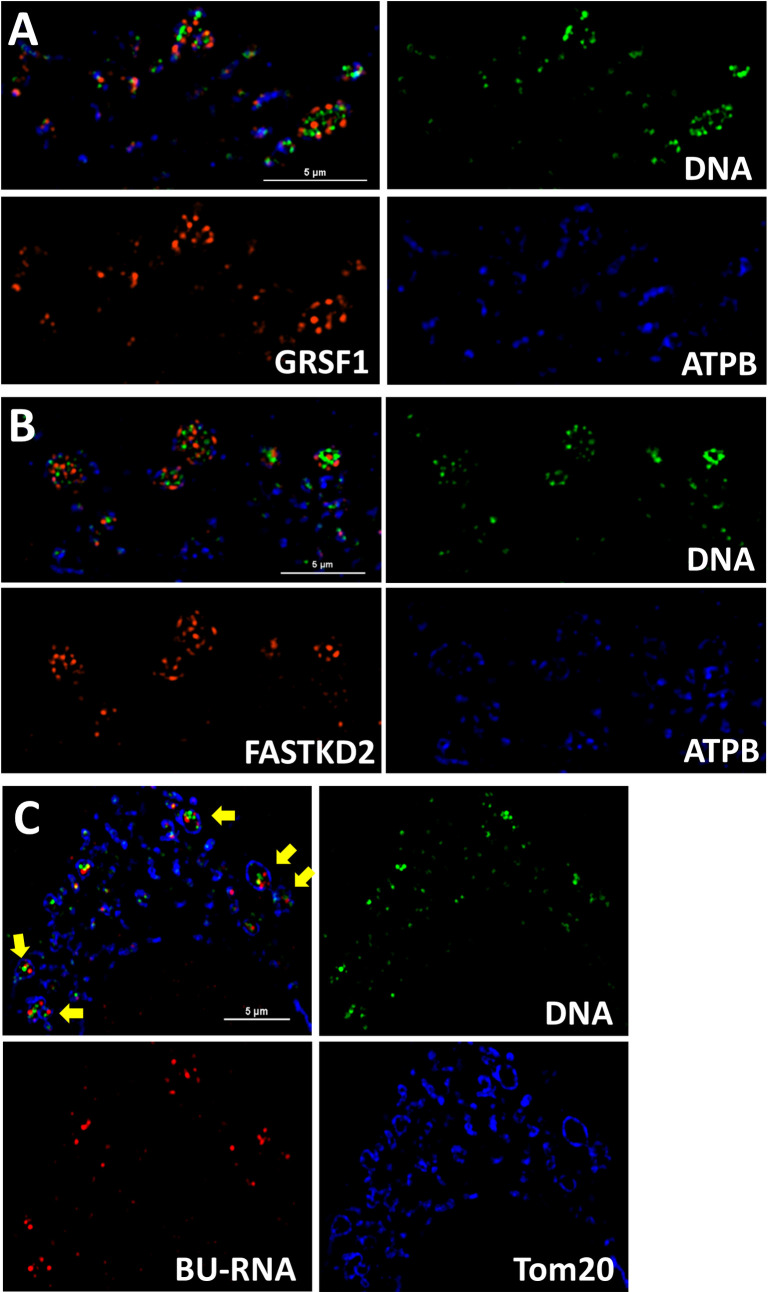
Mito-bulb nucleoid clusters retain transcriptional capability and discrete RNA processing centers.A. The MRG marker GRSF1 (red) is observed in individual punctate structures adjacent to mtDNA nucleoids (green) within mito-bulb like structures. Inner membrane marker ATPB is depicted in blue. Scale bar is 5 μm. Image is representative of six specimens. B. The MRG marker FASTKD2 (red) resides in individual punctate structures adjacent to mtDNA nucleoids (green) within mito-bulb like structures. Inner membrane marker ATPB is depicted in blue. Scale bar is 5 μm. Image is representative of 25 images collected for seven independent specimens. C. The nascent BU-labeled mtRNA (red) is observed in individual punctate structures adjacent to mtDNA nucleoids (green) inside both normal and bloated mitochondrial structures. Outer membrane marker Tom20 is depicted in blue. Arrows indicate swollen mitochondria with multiple foci of nascent mtRNA. Scale bar is 5 μm. Image is representative of 10 images of three independent experiments.